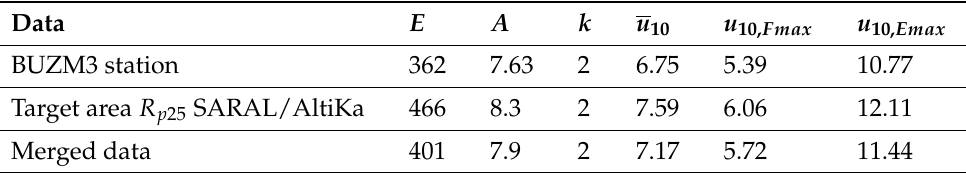
Table 9. Comparison on the Mean Energy Density (E), the Weibull parameters and the wind energy parameters at the BUZM3, at the target location using only AltiKa data and the target location using the merged data. u 10, Fmax and u 10, Emax are the most frequent u 10 and u 10 of the maximum wind energy carrier,